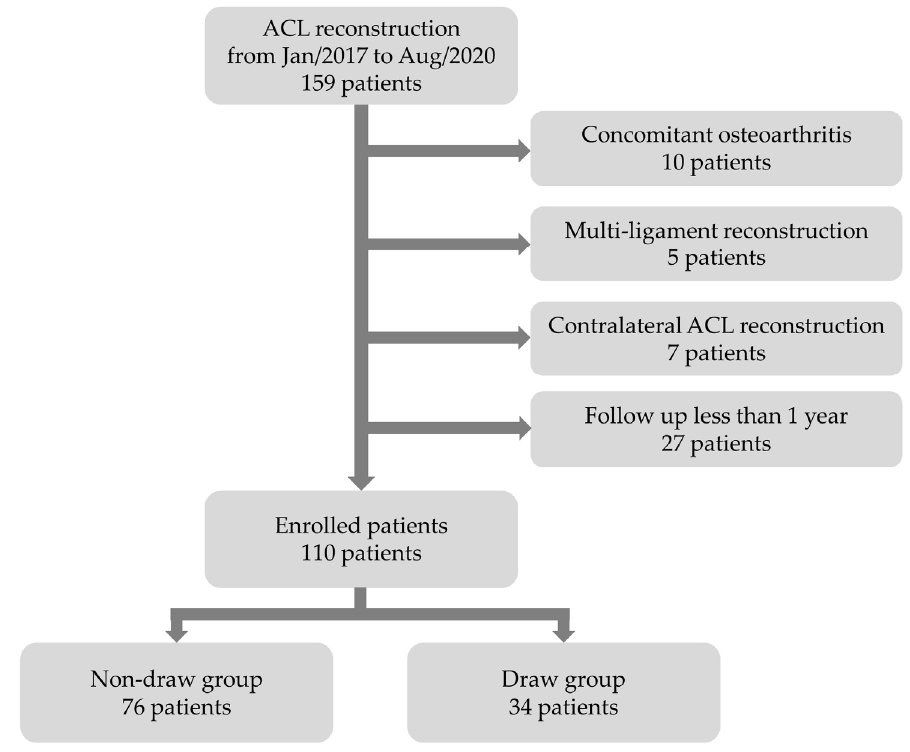
Figure 2. Flow chart describing the patients enrolled in the study.